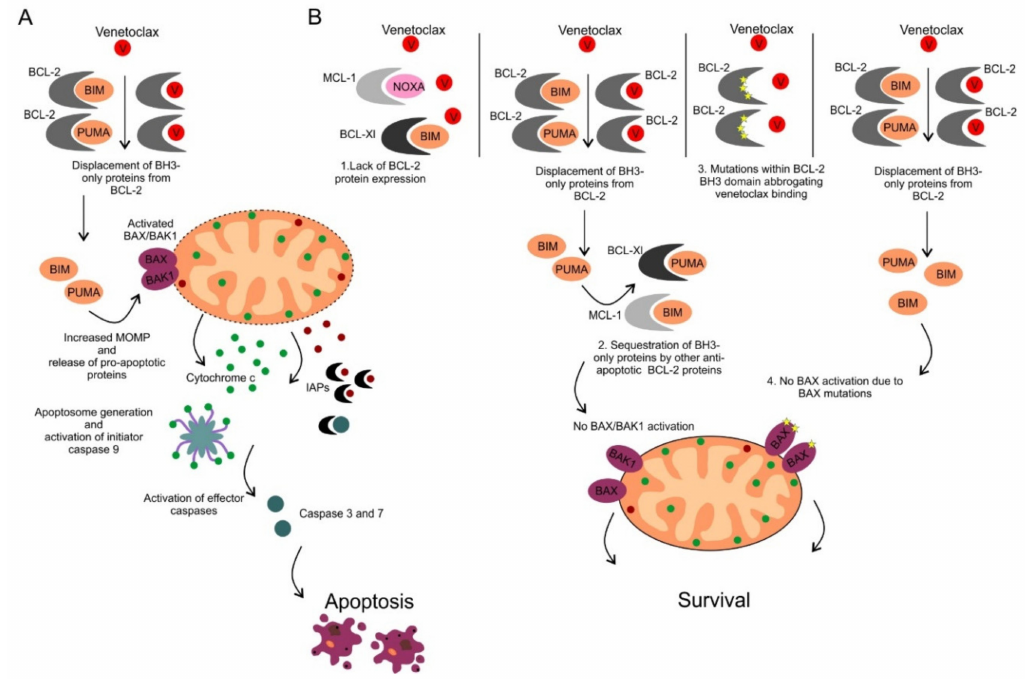
Figure 4. ( A ) Mechanism of action of venetoclax. Venetoclax binds to the BH3 domain of BCL-2 protein with subsequent release of proapoptotic proteins, activation of BAX / BAK1 and apoptosis induction. ( B ) Mechanisms of resistance to venetoclax. Four di ff erent mechanisms of inherited or acquired resistance to venetoclax include: 1. Lack of BCL-2 protein expression, 2. Overexpression of other anti-apoptotic BCL-2 proteins that sequester pro-apoptotic BH3-only proteins displaced from BCL-2 protein following its pharmacological inhibition by venetoclax, 3. Acquired mutations within the BH3 domain of BCL-2 abrogating venetoclax binding, 4. Acquired mutations of BAX preventing BAX activation and apoptosis